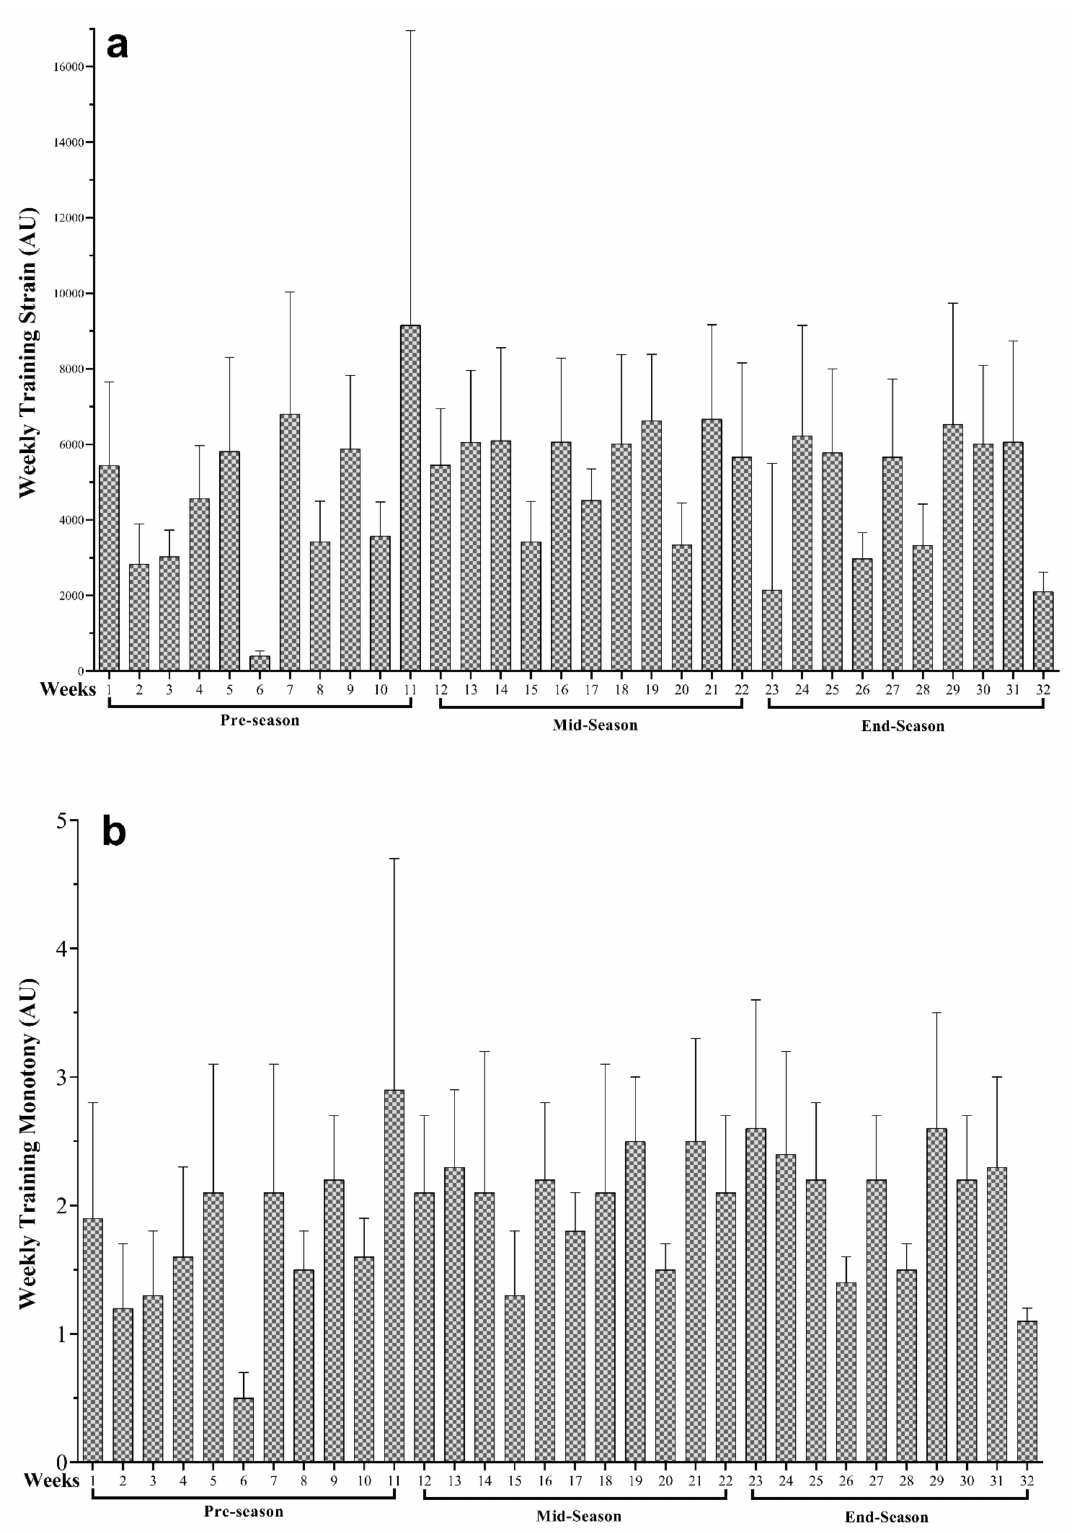
Figure 2. Descriptive statistics of ( a ) weekly average training strain and ( b ) weekly average training monotony and their variations across the preparation season be shown in three periods (pre-, mid- and end-season). Arbitrary units (AU). The results of comparative differences between three periods in the Table 6 has been displayed for wAW, wCW wACWR, wTM, and wTS. The analysis showed in wAW ( p = 0.04, F = 4.03, η p 2 = 0.31), wCW ( p = 0.002, F = 8.71, η p 2 = 0.49), wACWR ( p ≤